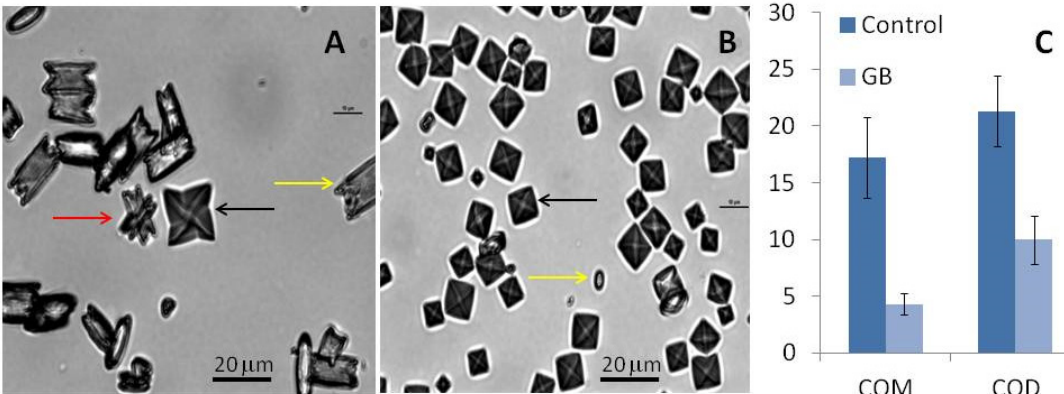
Figure 4. CaOx crystal micrographs obtained by inversion microscopy. Crystals were formed in the metastable solution of CaOx in the absence ( A ) and presence ( B ) of GB (0.1 mg/mL). Yellow arrows indicate monohydrated (COM) crystals, black arrows indicate di-hydrated (COD) crystals, and red arrow indicate tri-hydrated (COT) crystals. Average size of formed crystals ( C ). Scale bar represents 20 µ m.